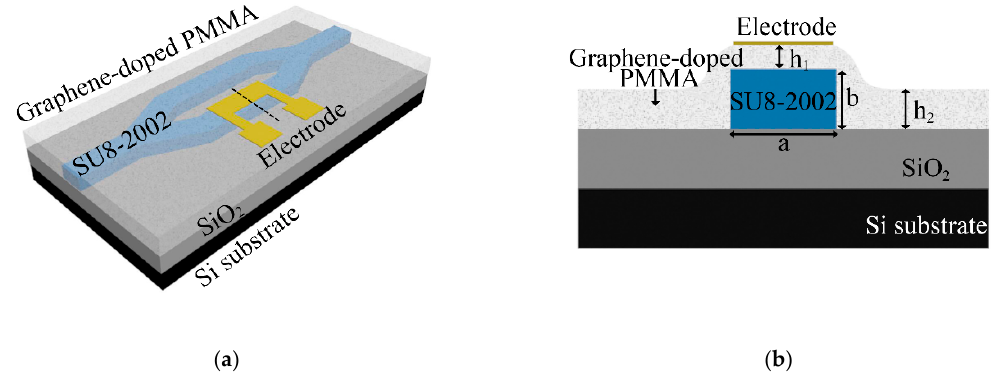
Figure 2. The arc cladding structure of the graphene-doped thermal optical (TO) switch in ( a ) a three-dimensional direction and ( b) a cross-sectional direction.